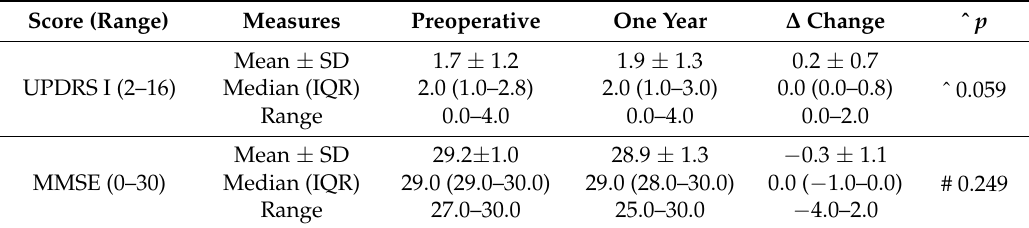
Table 4. Changes in UPDRS I and MMSE scores.